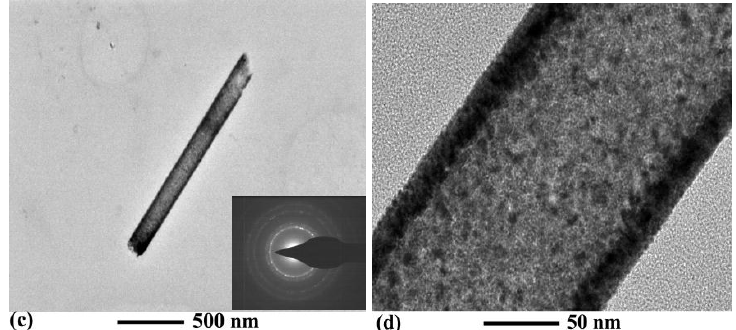
Figure 1. Scanning electron microscopy (SEM) images of Ni nanotube arrays with ( a ) low magnification and ( b ) high magnification; Transmission electron microscopy (TEM) images of a single Ni nanotube with ( c ) low magnification and ( d ) high magnification, showing an outer diameter of 150 nm, a wall thickness of 15 nm, and a length of 1.2 ± 0.3 µm. The inset shows the corresponding selected area electron diffraction (SAED) pattern.